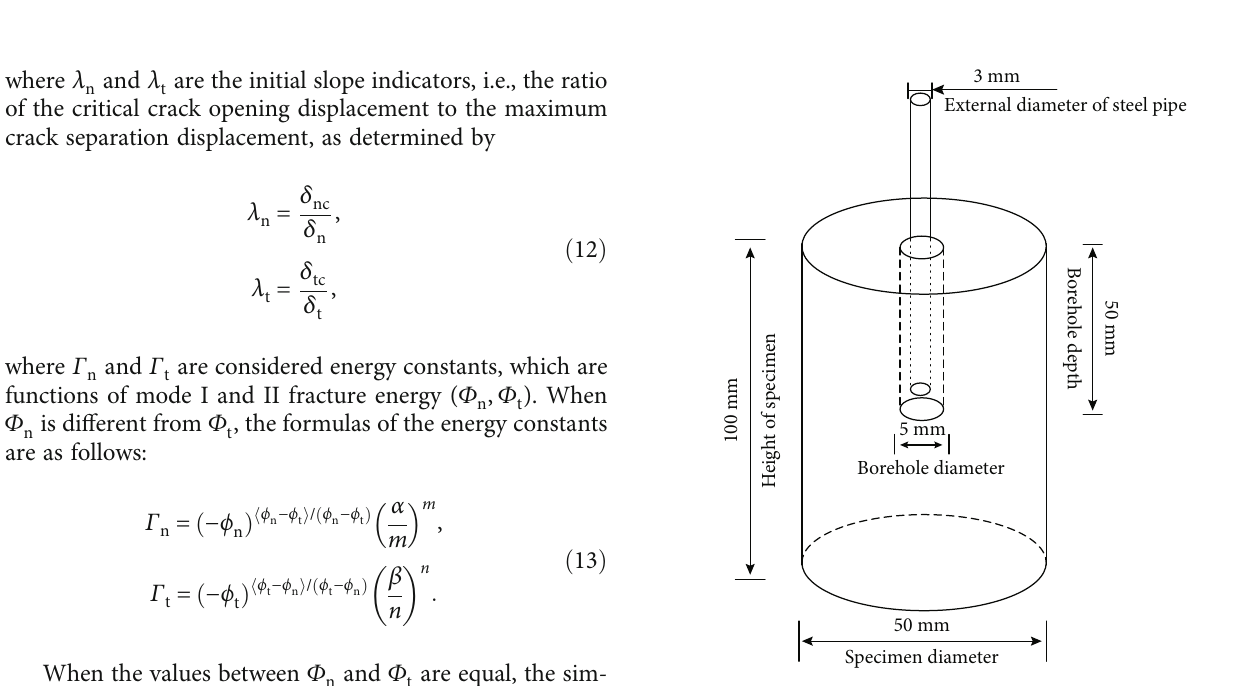
Figure 6: Con fi guration of the prepared